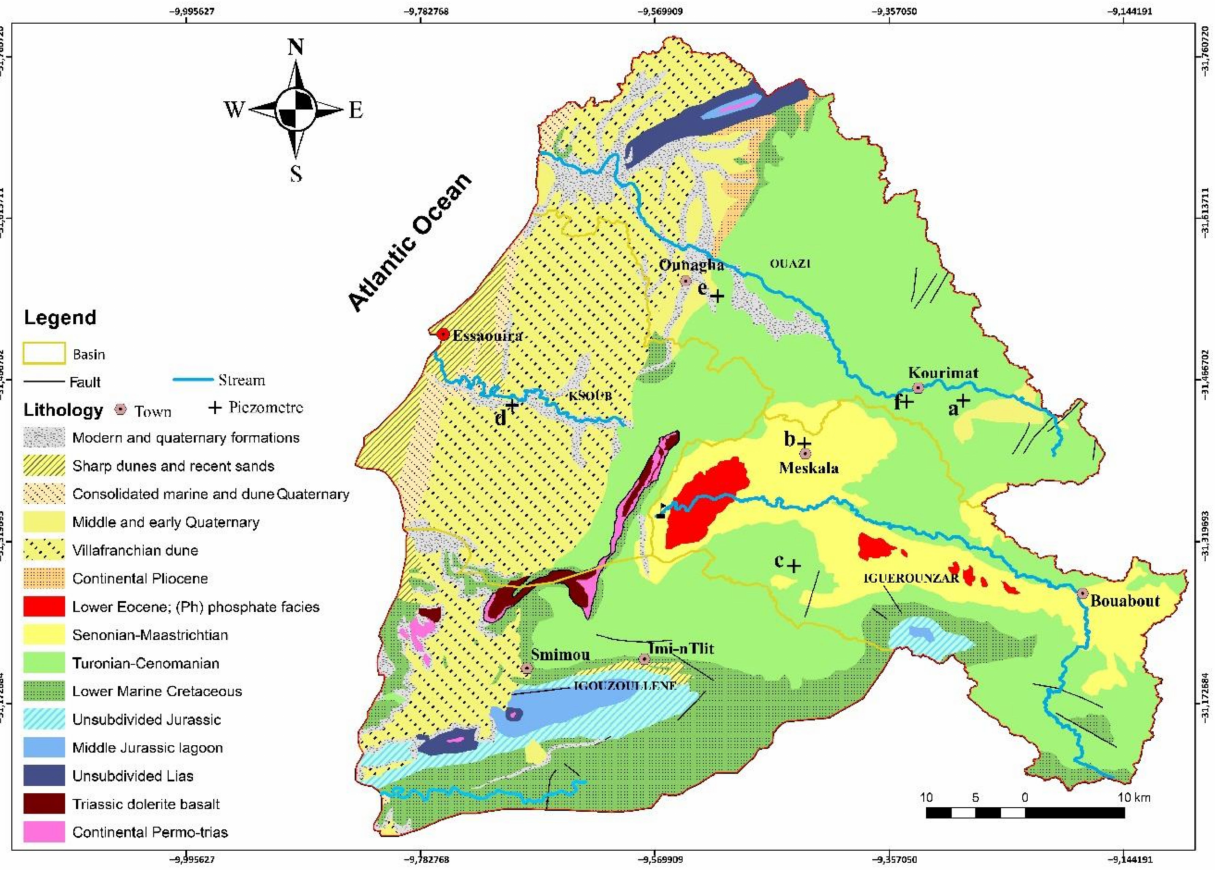
Figure 2. Geological map and location of the piezometric monitoring points (modified from